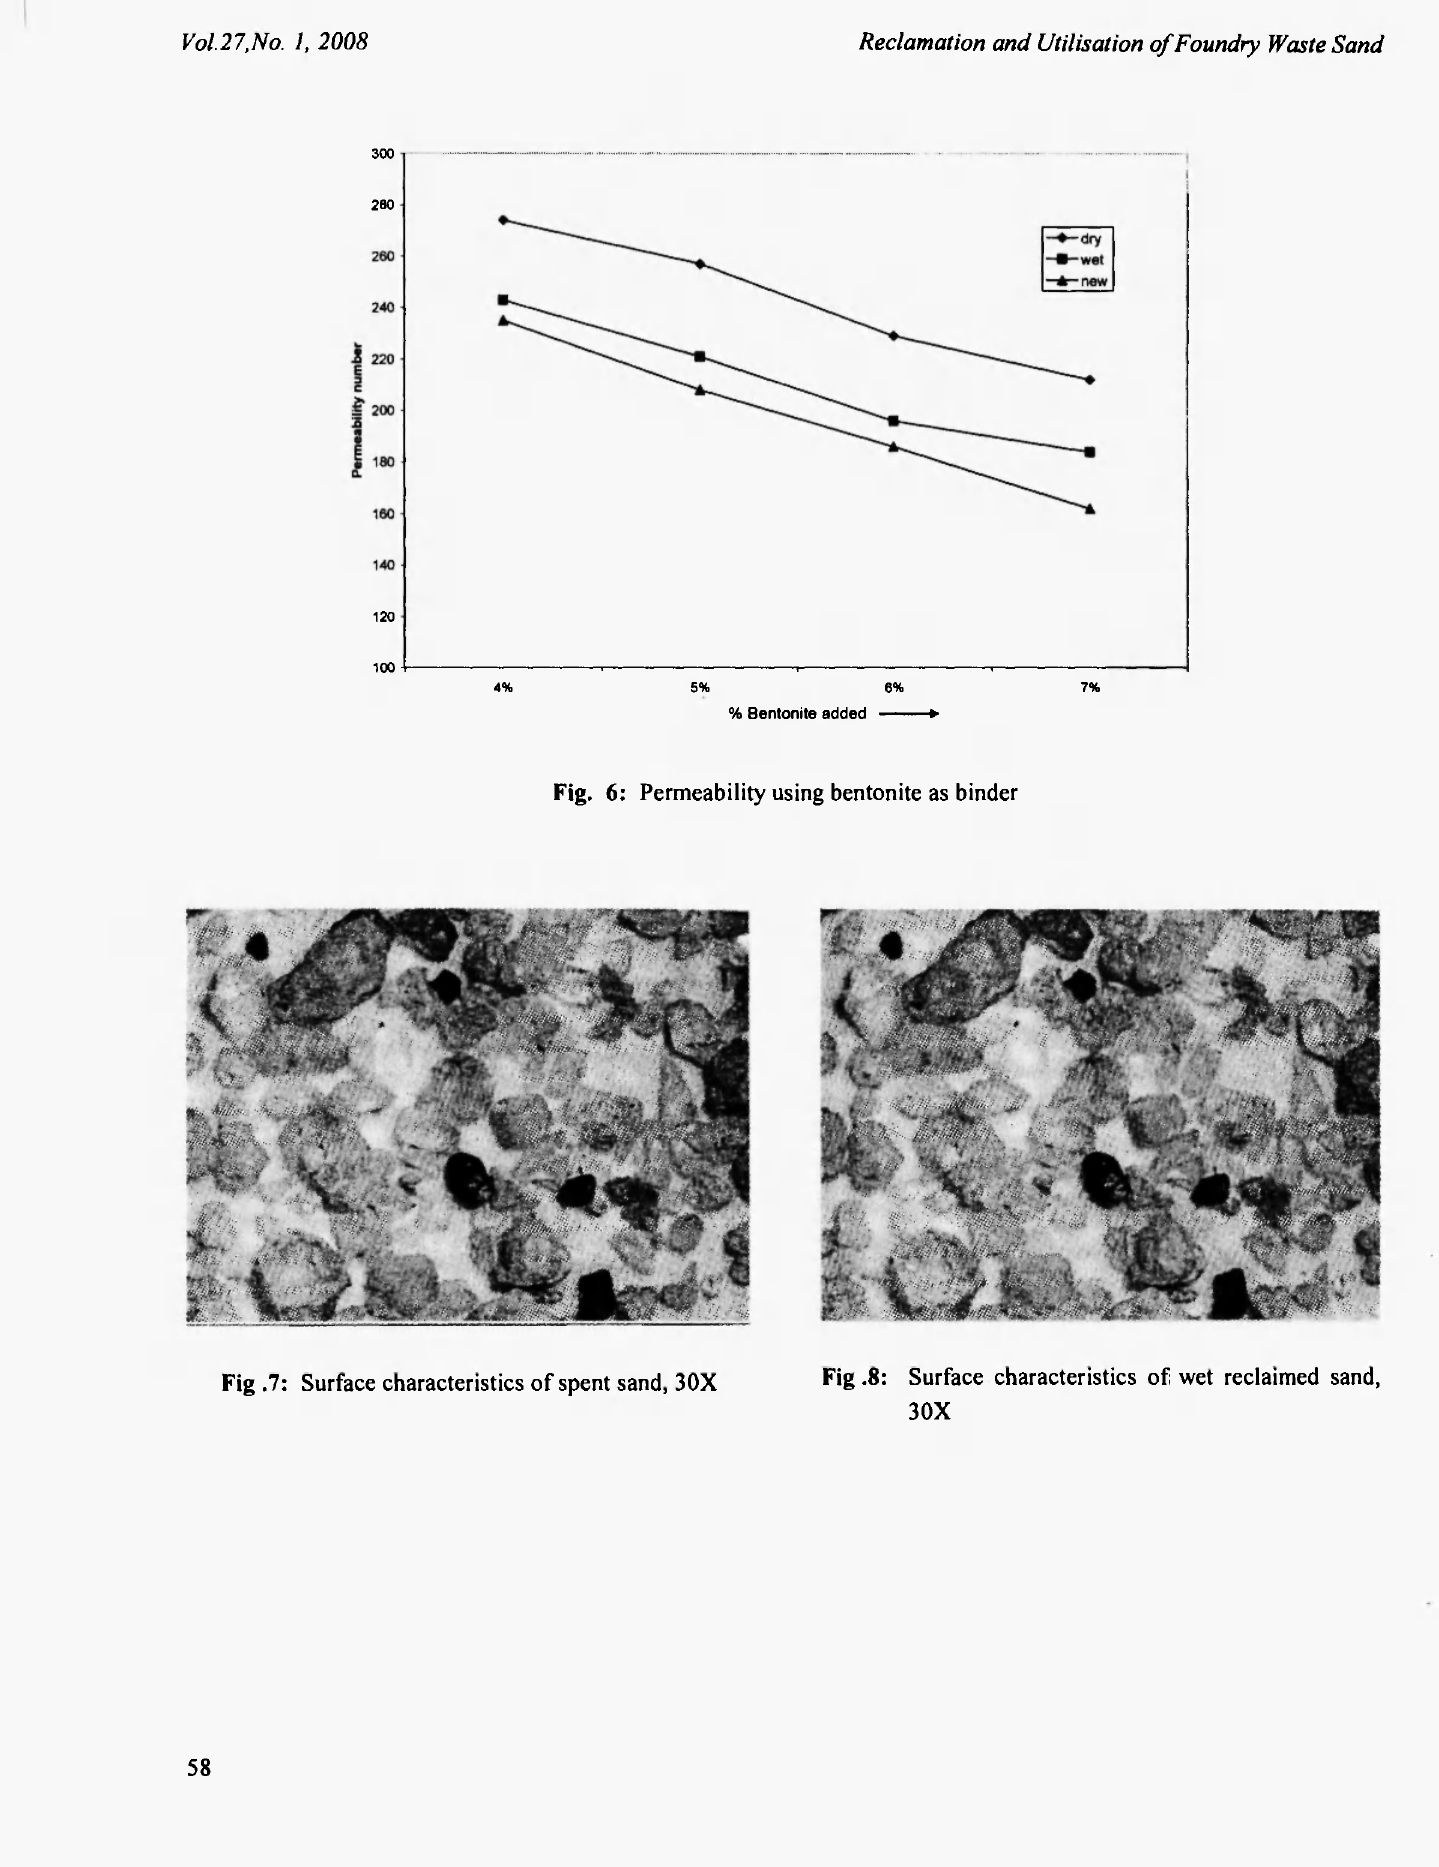
Fig. 6: Permeability using bentonite as binder